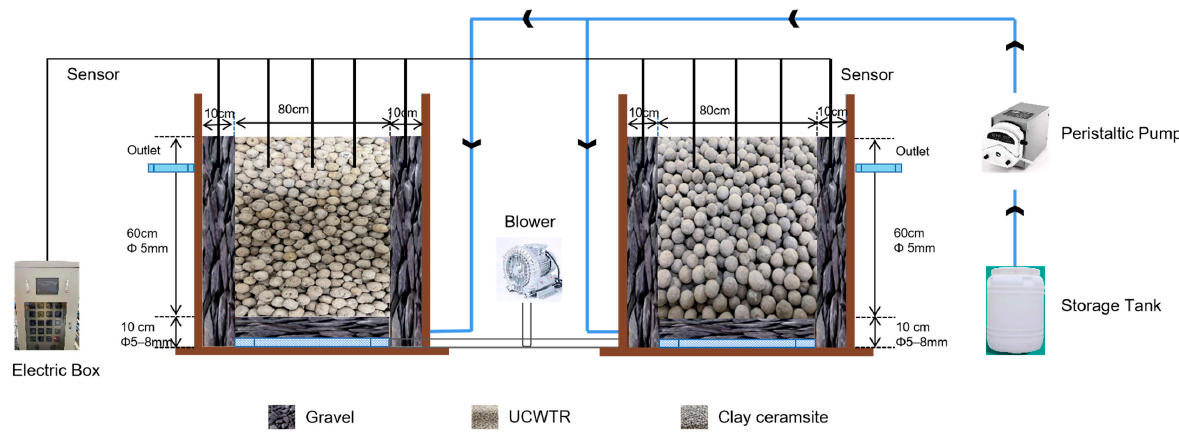
Figure 1. Schematic diagram of a simulated CWs device.